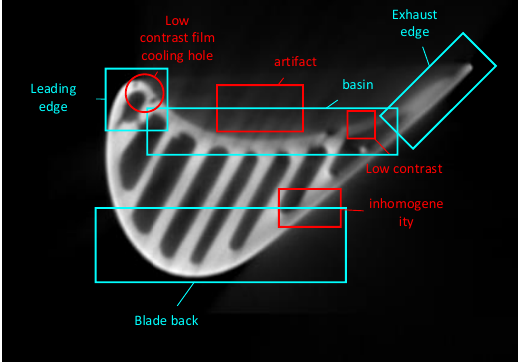
Figure 1. ICT image of the hollow turbine blade.